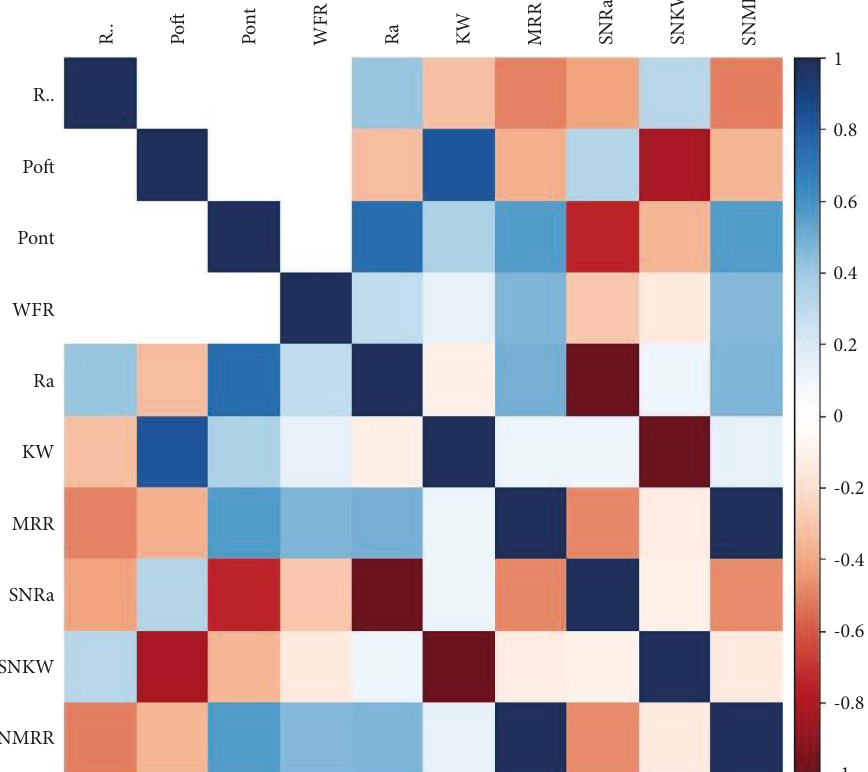
Figure 3: Hierarchical clustering of the correlation coefficient matrix of input variables.